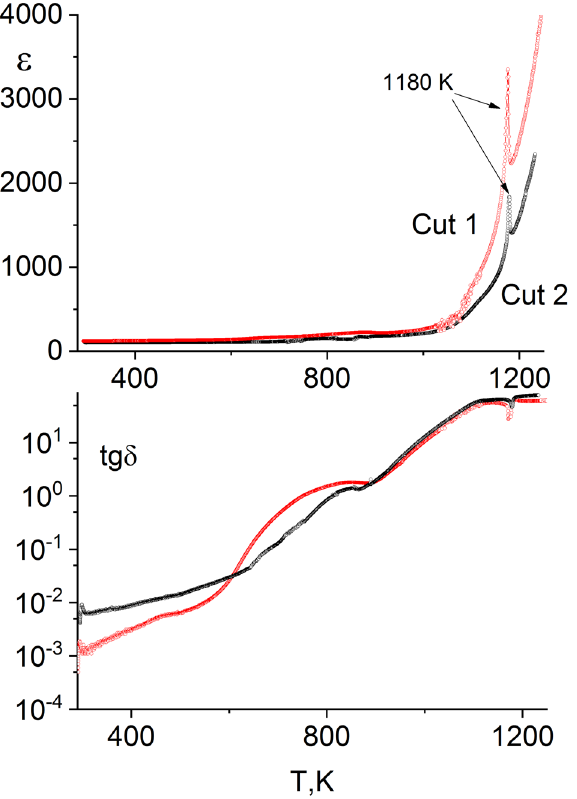
Figure 6. Temperature dependences of the permittivity (ε) and the dielectric loss tangent (tan δ) of hot-pressed sections of BTN plates at the frequency of the measuring field of 1 MHz: the upper section is the permittivity (ε), the lower section is the dielectric loss tangent (tan